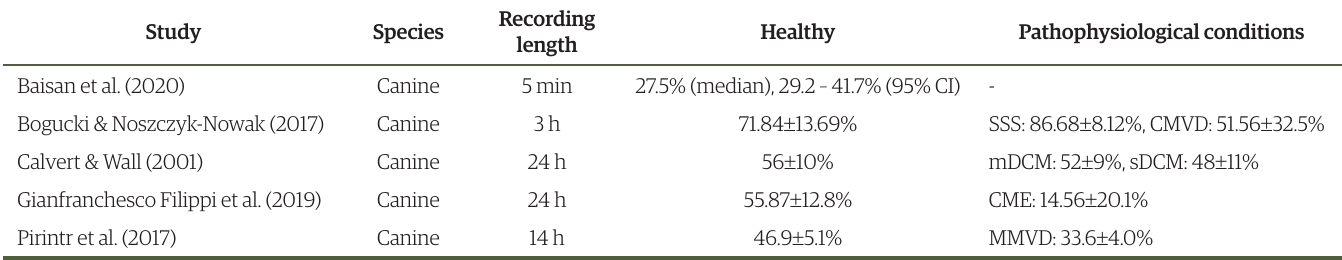
Table 5. Summary results of selected studies from the literature, depicting the recording length for data acquisition and the pNN50 values for healthy animals or those presenting pathophysiological